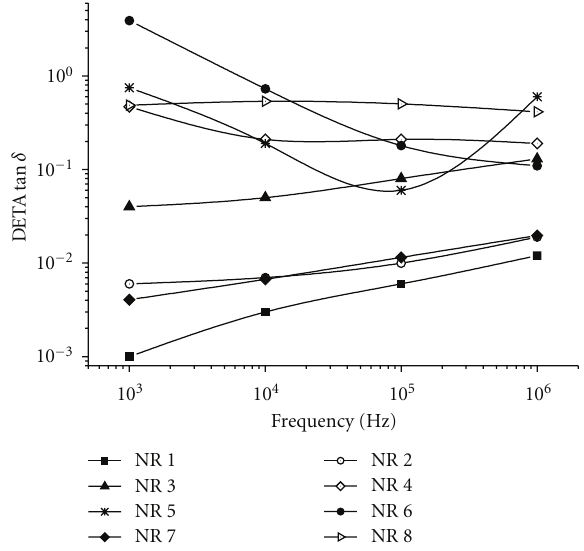
Figure 5: Frequency dependence of the dielectric loss angle tangent (DETA tan δ ) for composites comprising di ff erent amounts of Printex XE-2B or Corax N220 at 30 ◦ C.